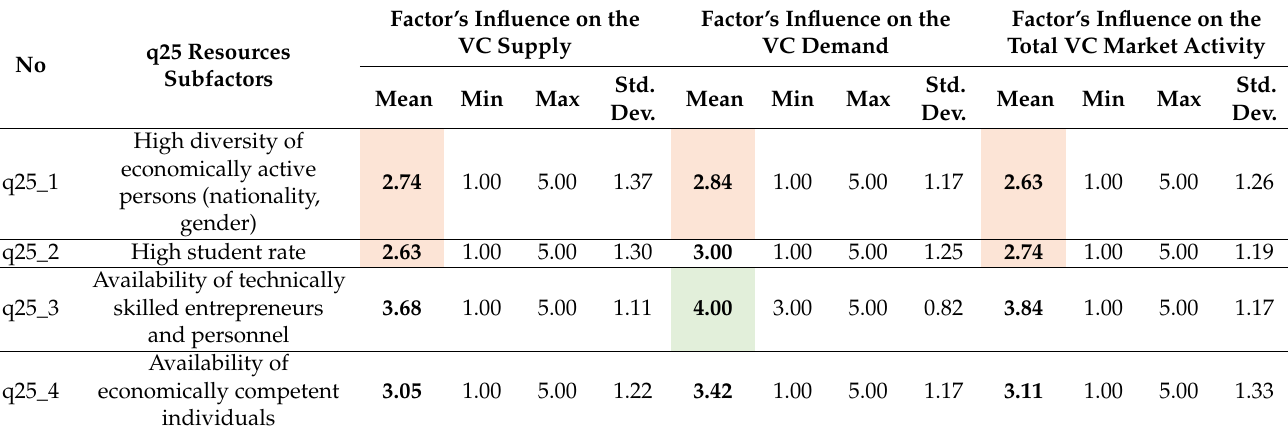
Table 15. The subfactors related to the human